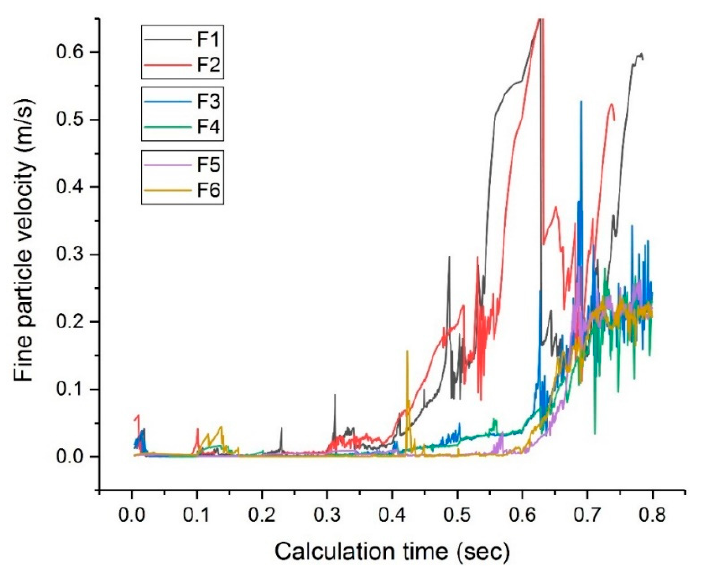
Figure 21. Evolution of coarse particle velocity in di ff erent layers (F1 and F2 are fine particles in the top layer; F3 and F4 are fine particles in the middle layer; and F5 and F6 are fine particles in the bottom layer). Figure 22 is mass-loss measurement of the numerical model. When t = 0–0.1 s ( (cid:1861) (cid:3041) = 1.0 ), the